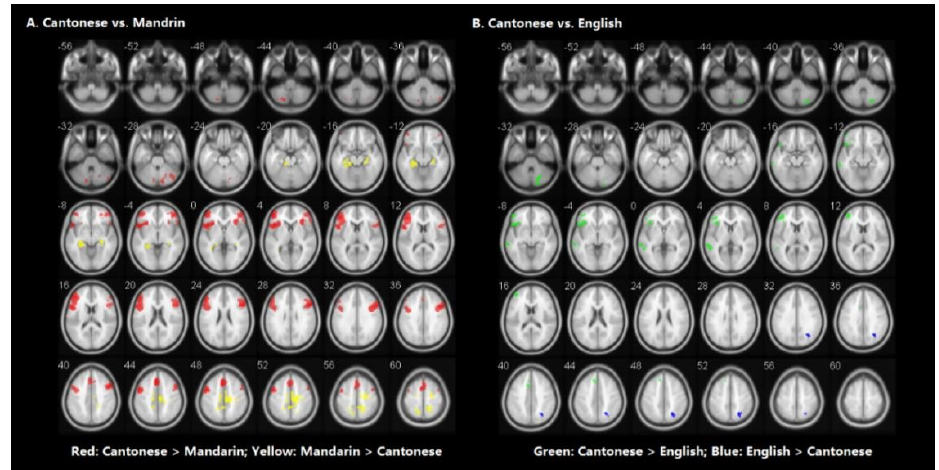
Figure 3. Brain activity for the contrast of rhyming minus control for the group comparisons in visual modality. (Panel A ) represents the comparison between Cantonese and Mandarin. (Panel B ) represents the comparison between Cantonese and English. Statistical significance was set as p < 0.001 with voxels ≥ 40.